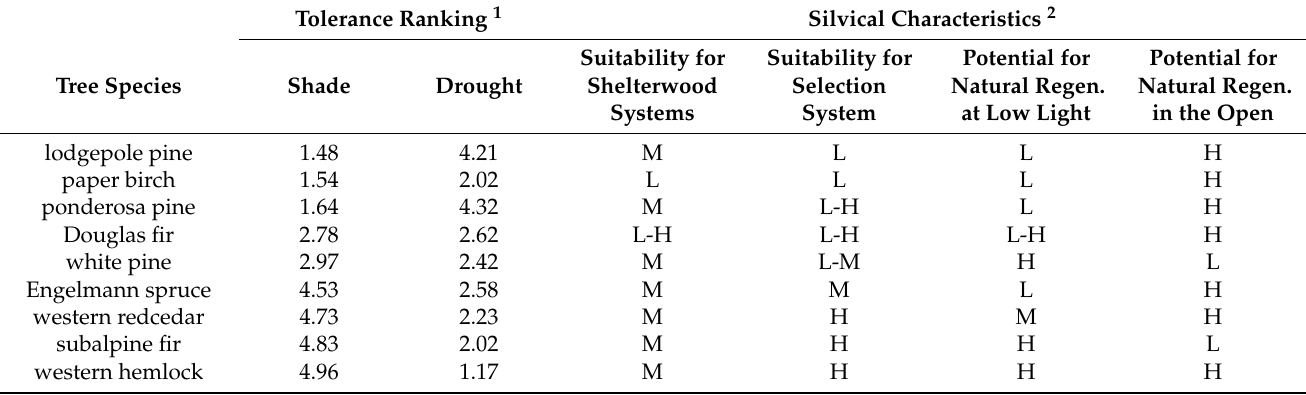
Table 1. Comparative tolerance to main stress factors and key silvics of the 9 Interior Cedar Hemlock (ICH) tree species planted in strip-cut experiment. Tolerance Ranking 1 Silvical Characteristics 2 Suitability for Suitability for Potential for Potential for Tree Species Shade Drought Shelterwood Selection Natural Regen. Natural Regen. Systems System at Low Light in the